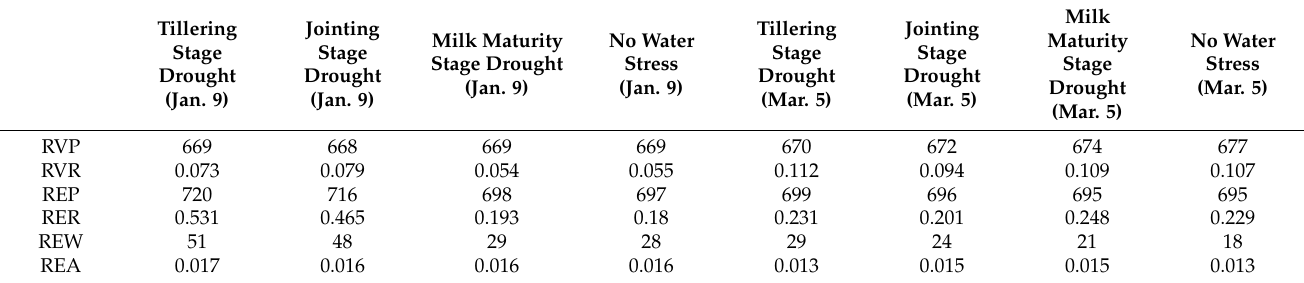
Figure 3. Red-edge spectra for different wheat growing stages. (S represents the tillering stage drought; JS represents the jointing stage drought; MS represents the milk maturity stage drought; and NS represents no water stress. Furthermore, 0109 represents the spectra obtained on Jan 9, while 0305 represents the spectra obtained on Mar 5. Table 4. Calculation of the six red-edge parameters for wheat exposed to drought during differ- ent stages.